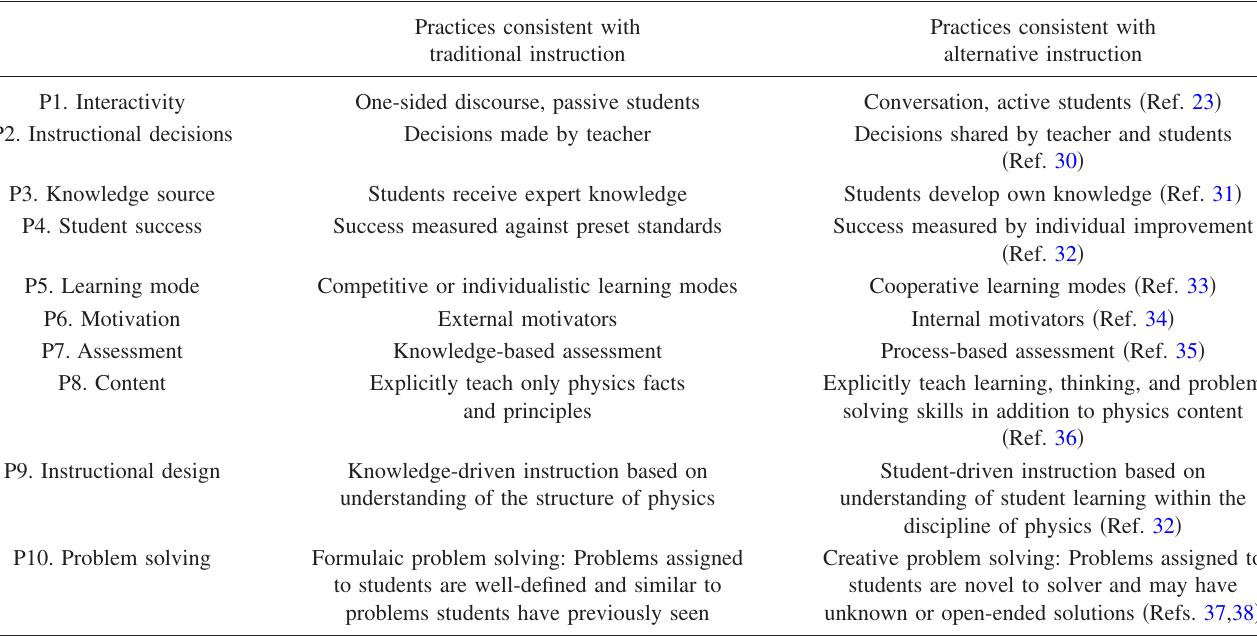
TABLE II. Main categories of